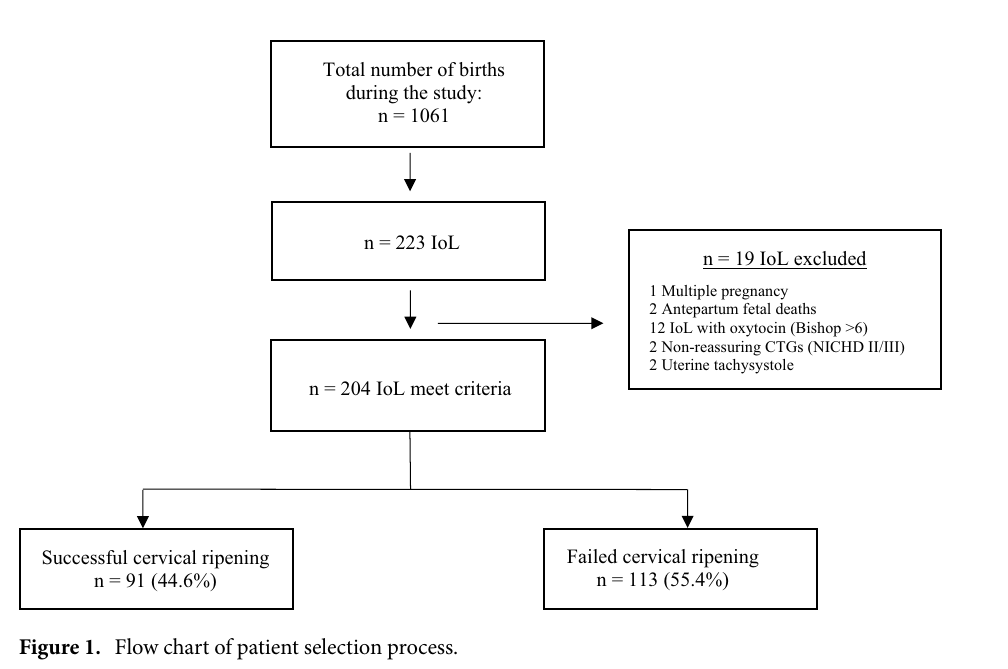
Figure 1. Flow chart of patient selection